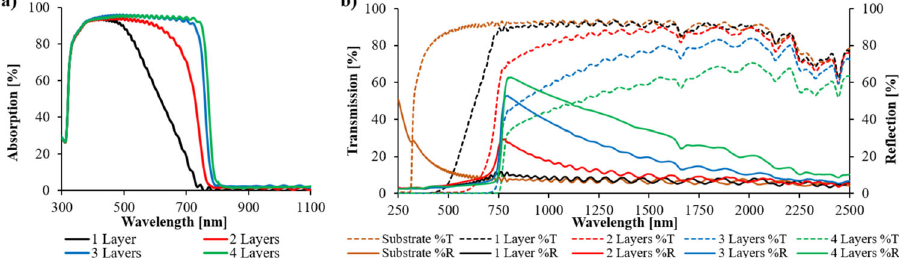
Fig. 2 Optical properties of the printed CH 3 NH 3 PbI 3 − x Cl x perovskite layer. a Absorption spectra of printed CH 3 NH 3 PbI 3 − x Cl x perovskite layers. b Transmission and re fl ection spectra of printed CH 3 NH 3 PbI 3 − x Cl x perovskite layers and Novele TM IJ-220 PET